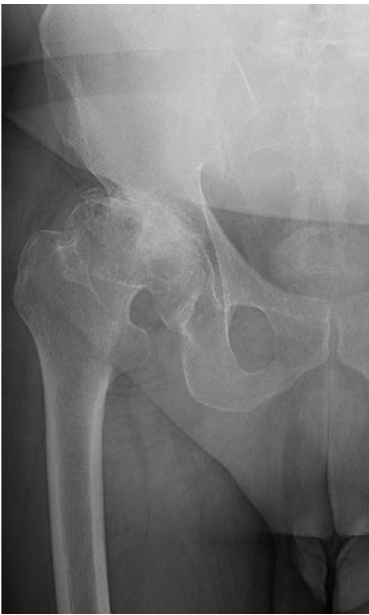
Figure 12. Pre-oprative X-ray.